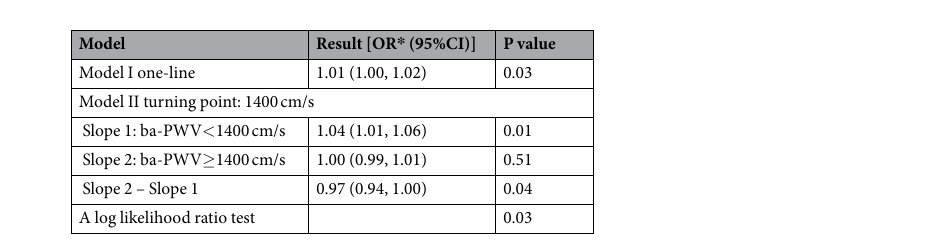
Table 3. Threshold effect analysis of baseline ba-PWV on the risk of new carotid plaque formation using piecewise linear regression model. * OR, odds ratio, represented the effect for every 10 cm/s increase of